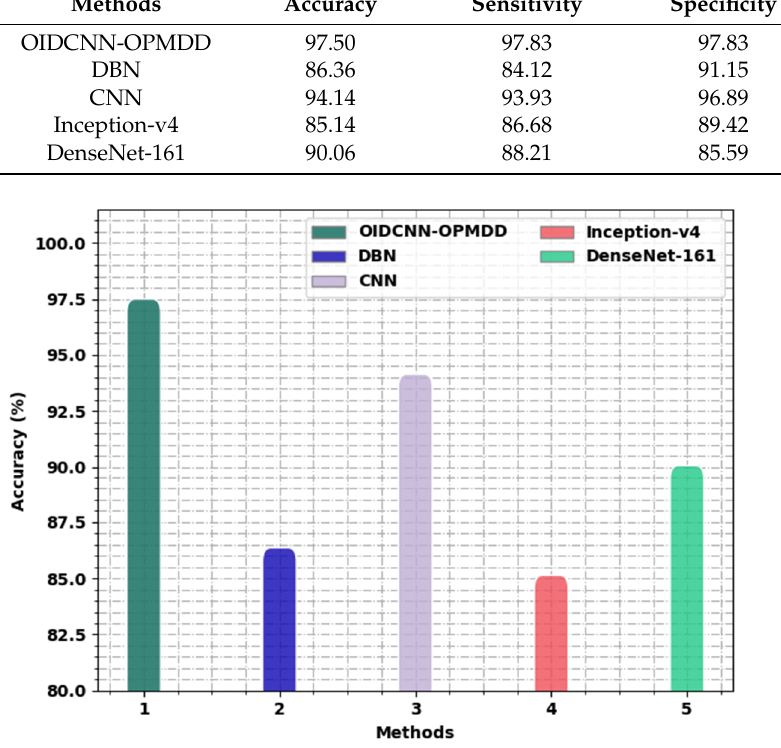
Figure 12. accu y analysis of the OIDCNN-OPMDD approach with existing Figure 12. Accu_y analysis of the OIDCNN-OPMDD approach with existing algorithms.